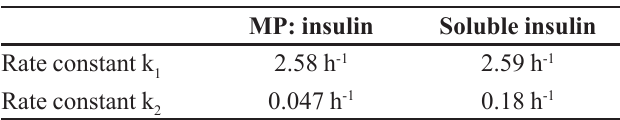
TABLE II - Kinetic parameters from the pharmacological evaluation of the glycemic effect of MP-insulin. Parameters were obtained from data in Figure 3